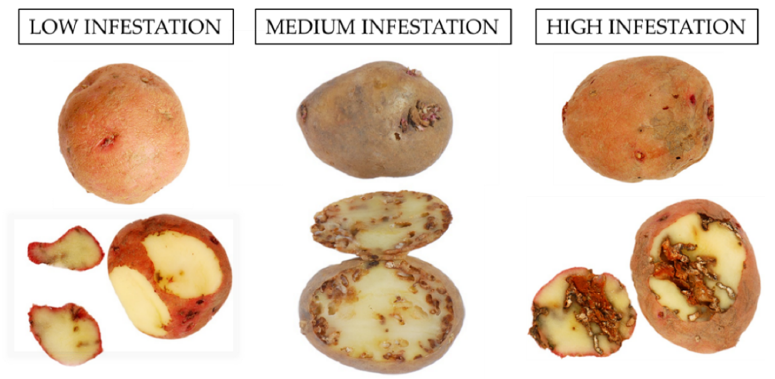
Figure 4. External and dissection views of infested control potatoes with Tecia solanivora. Low infestation (tubers classified by the farmer) and medium and high infestation (tubers infested in the laboratory). Photos: M.G. Lobo and F. Correa.